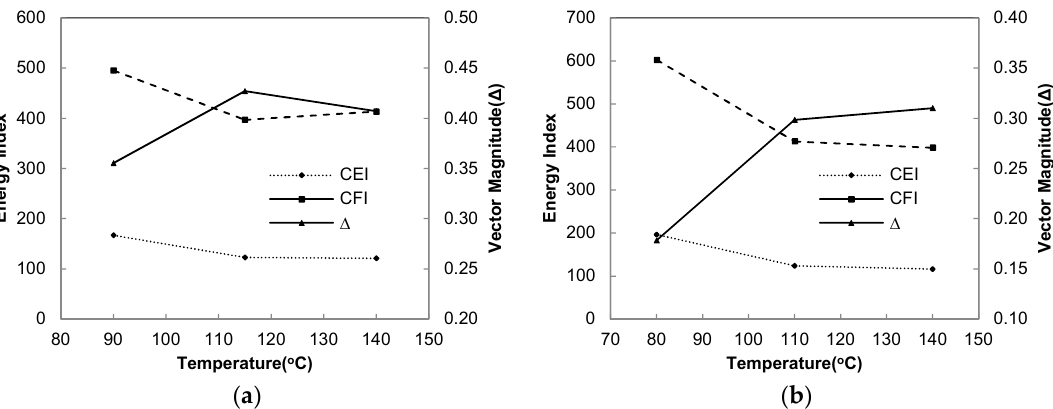
Figure 10. Comparisons of the energy indices and the ∆ as function of temperature: ( a ) PG64-28 mixtures; ( b ) PG58-28 mixtures.